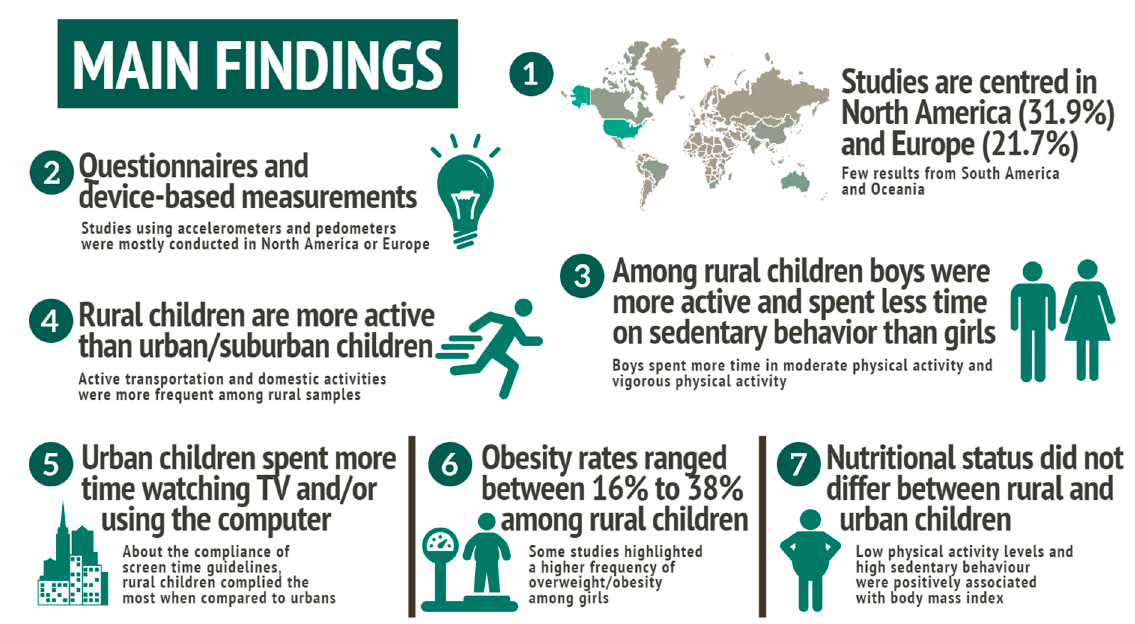
Figure 2. Summary of the main findings.